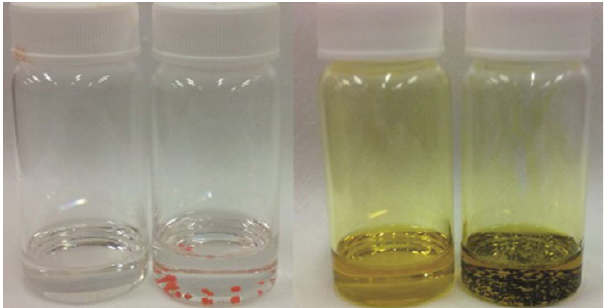
Figure 1 | Effect of acid addition to growth solution. Photograph of the acid-initiated crystallization for the bromide (clear solution) and iodide (yellow solution) systems; the vials with no crystals were kept for 24 at the crystallization temperature with no added acid and the vial with crystals had acid added B 2h before the picture being